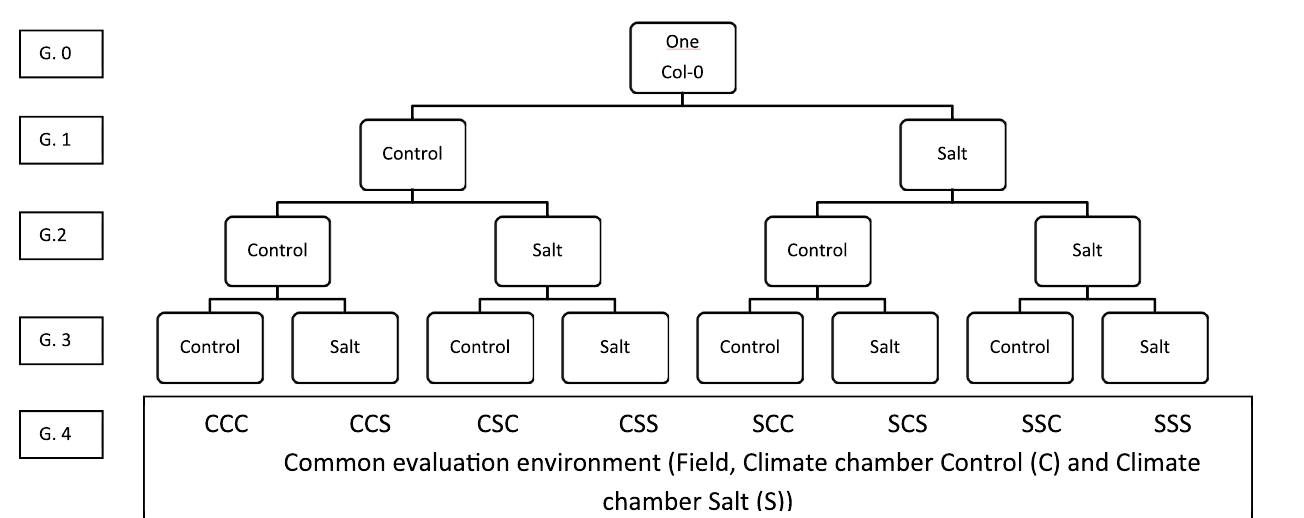
Fig 1. Origin of the experimental groups. A single A . thaliana plant (ecotype Col-0) served as a founder for the pedigree. Plants were grown for three generations either in a salt or in a control environment. Performance of offspring of the third generation (i.e., G.4) was tested in three distinct environments: a field environment, a climate chamber control and climate chamber salt